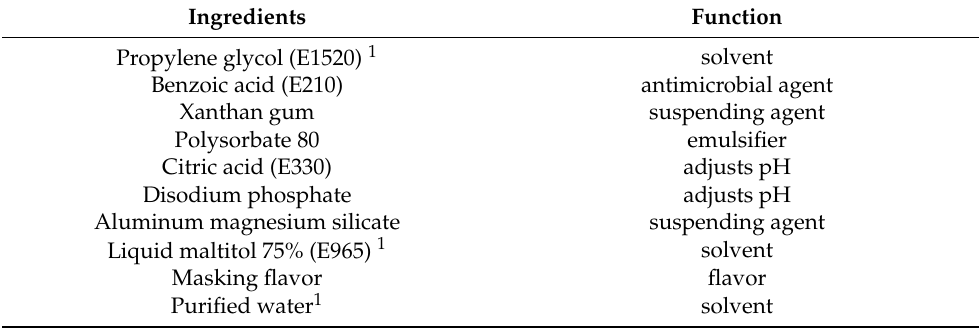
Table 2. Ingredients of warfarin placebo (excipients) as received from the Pharmadata SA. Ingredients Function Propylene glycol (E1520) 1 solvent antimicrobial